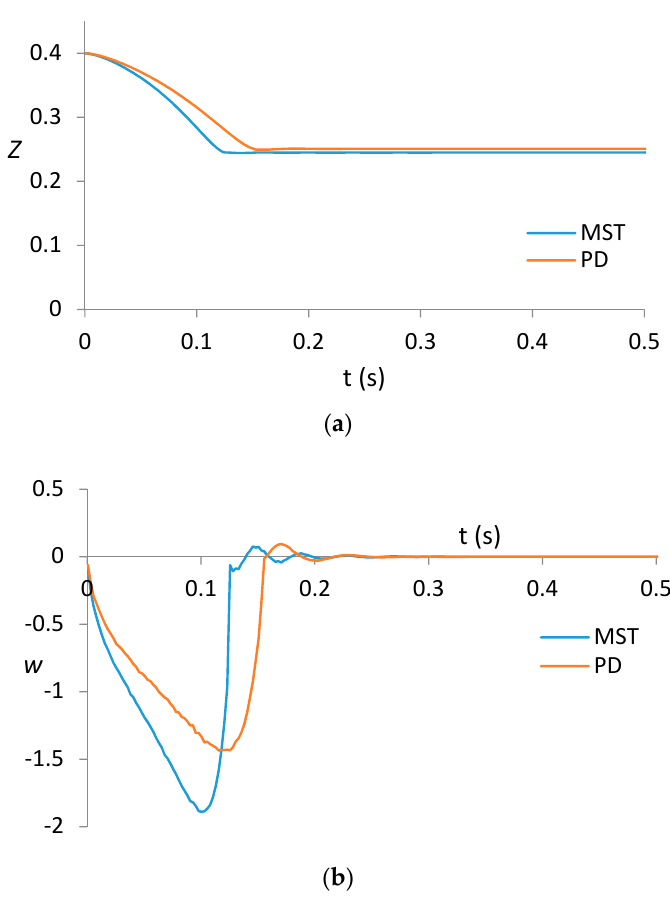
Figure 9. The z -components of particle position ( z ) and velocity ( w ) for the PD and MST methods are shown as functions of time. a = 0.05 and ε p = 1.5 and the initial particle position is (0.35, 0.25, 0.40). ( a ) z and ( b ) w . The dimensionless parameters are: Re = 0.113, P E = 3080, and P 4 = 0.668.